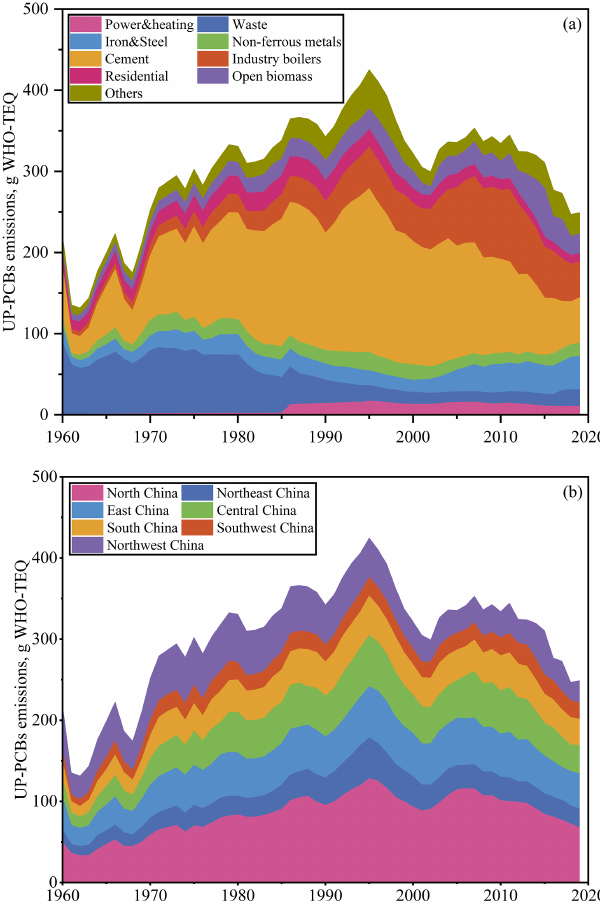
Figure 4. Temporal variations in UP-PCBs for different sources (a) and regions (b)